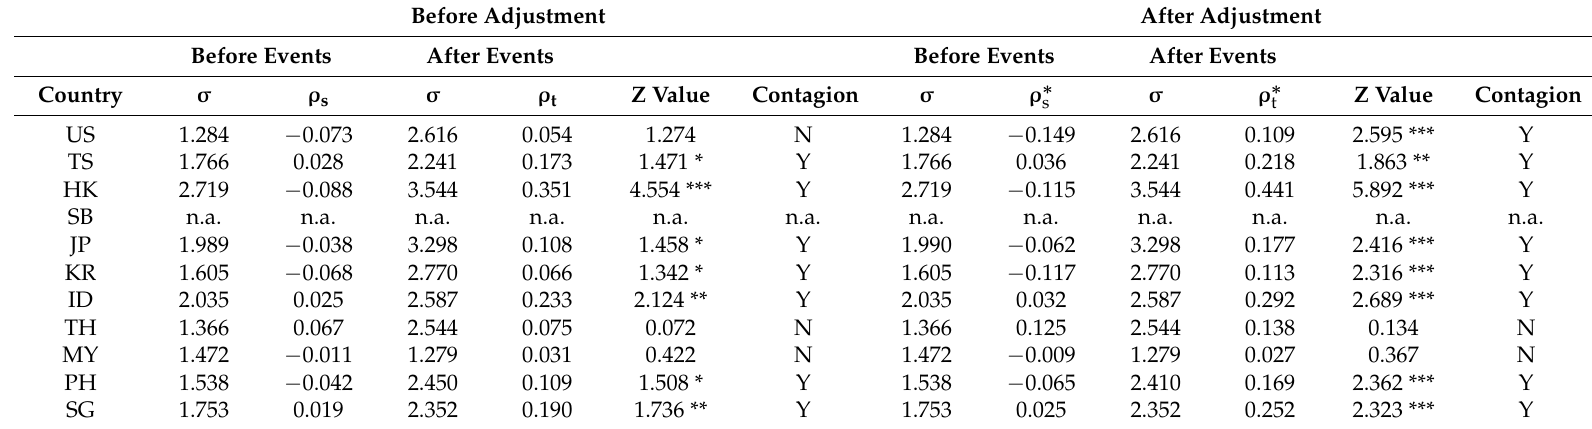
Table 6. The Correlation Coefficients after heteroscedasticity biases adjustment: China’s Sichuan earthquake. Before Adjustment After Adjustment Before Events After Events Before